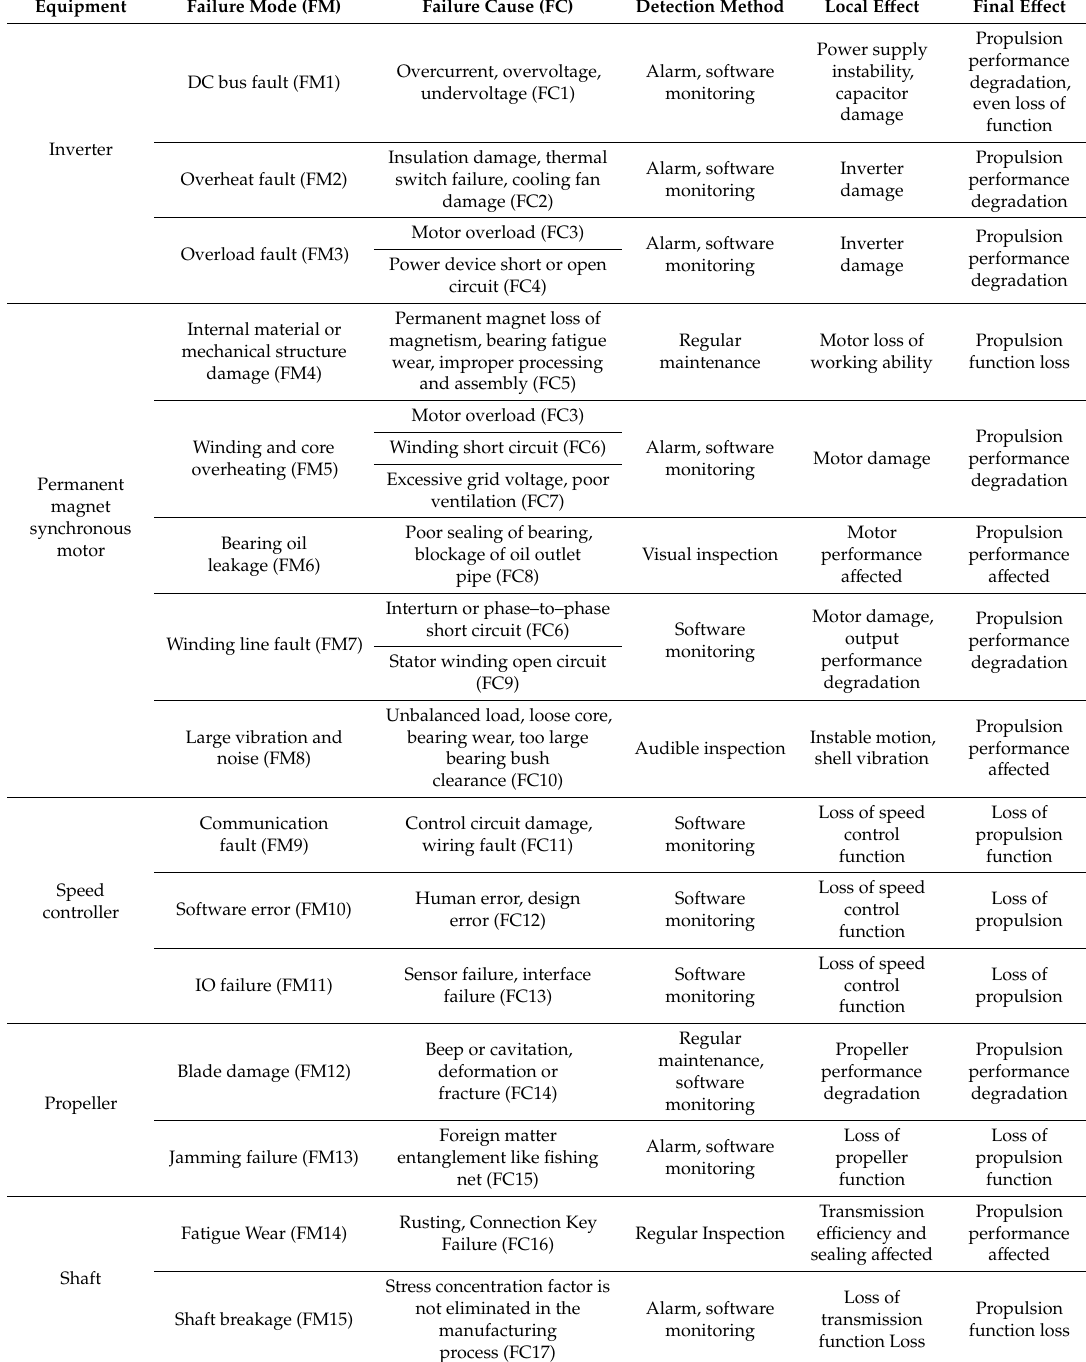
Table 5. Failure mode and e ff ects analysis (FMEA) of the propulsion subsystem for a shipboard IEPS. Equipment